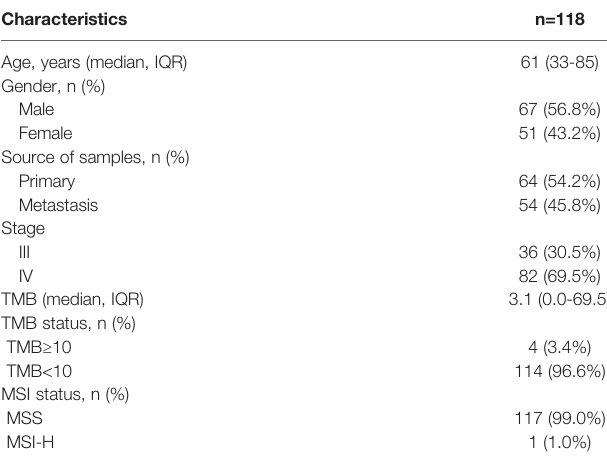
TABLE 1 | Clinical characteristics of